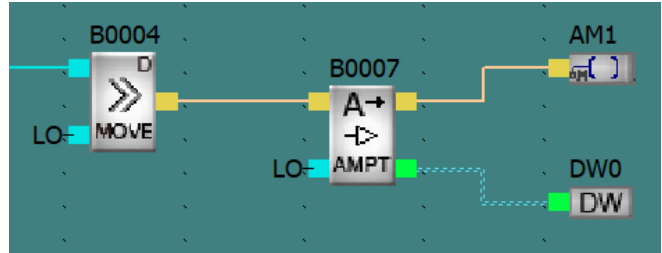
Figure 4. Stage 2 of the flow measurement—screenshot from the software.